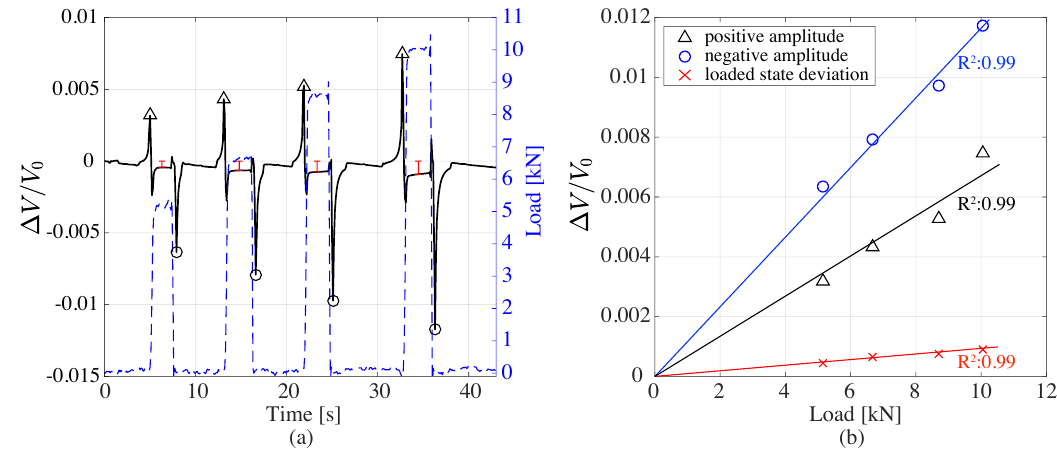
Figure 7. The results of the rapid loading–unloading tests done on the pavement sample (the LM case): ( a ) the generated voltage pulses along with loading–unloading pattern, where the red lines represent the deviation from 0 during the loaded period of the sample; ( b ) readings of positive and negative amplitude peaks and deviation from unloaded state along with the linear fits and R 2